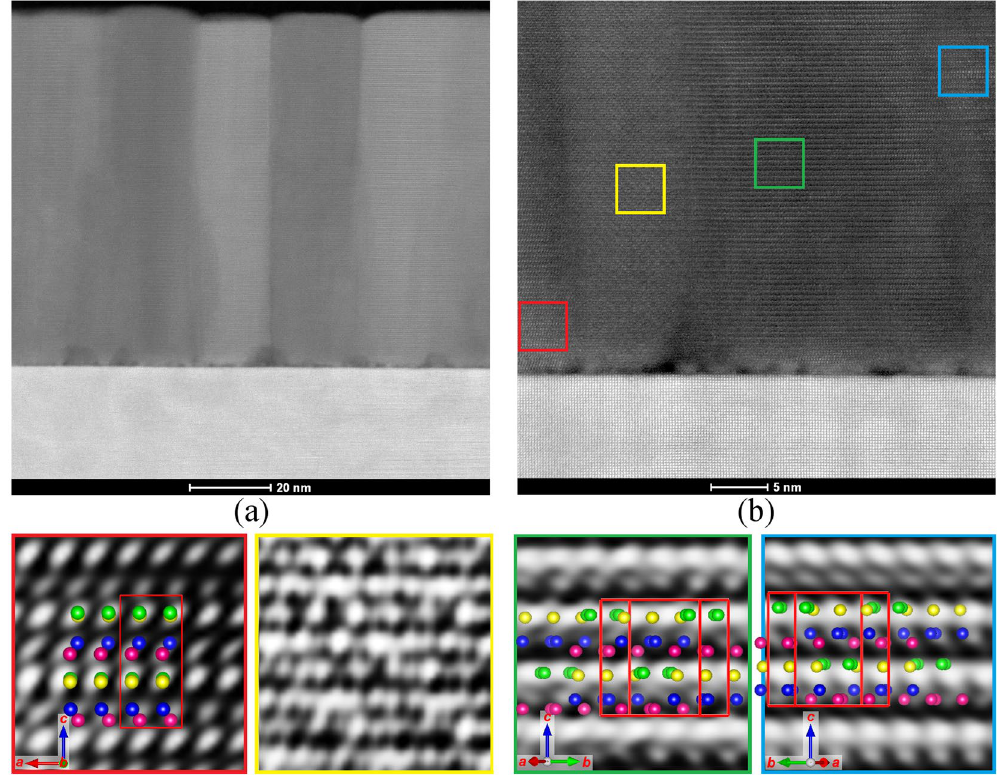
Figure 2. ( a ) STEM image of a circa 100 nm thick film of ε -Fe 2 O 3 on YSZ (100) highlighting the formation of pillar-like twins, ( b ) detail of the interface between the substrate and the film, evidencing the formation of ‘bubbles’ of a foreign phase (most likely Fe 3 O 4 ) at the interface. Below: high-magnification of the 4 colored selected areas overlapped with simulated ε -Fe 2 O 3 structures rotated according to the proposed epitaxy relationships to further prove the existence of different growth in-plane orientation. If the orientation in the red box, with the b axis pointing out-of-plane is taken as 0°, the unit cells depicted in the other boxes are rotated, respectively by 300° (green), and 120° (light blue) (note that the 2 last unit cells (green) and (light blue) have a 180° rotational symmetry). No match was found for the yellow selection, probably due to the overlap of two different growth domains in the STEM